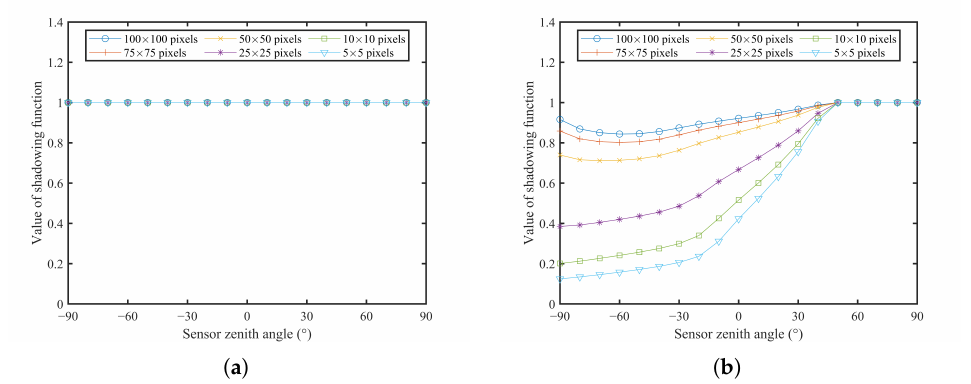
Figure 3. Hapke model. Variation of the shadowing function under various illumination observations of the solar location’s primary plane: ( a ) (0 ◦ , 150 ◦ ) and ( b ) (45 ◦ , 150 ◦ ).